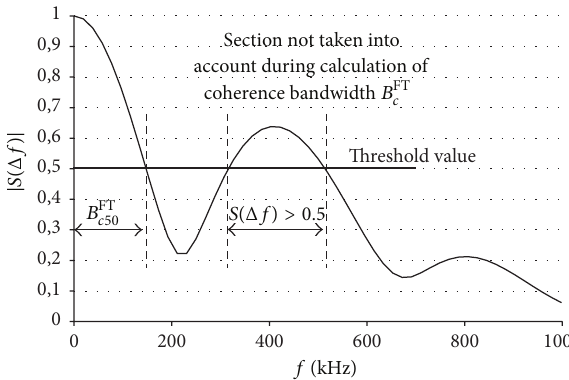
Figure 2: Evaluation of coherence bandwidth from Fourier trans- form of power delay profile in case when 𝑆(Δ𝑓) crosses predefined threshold value several